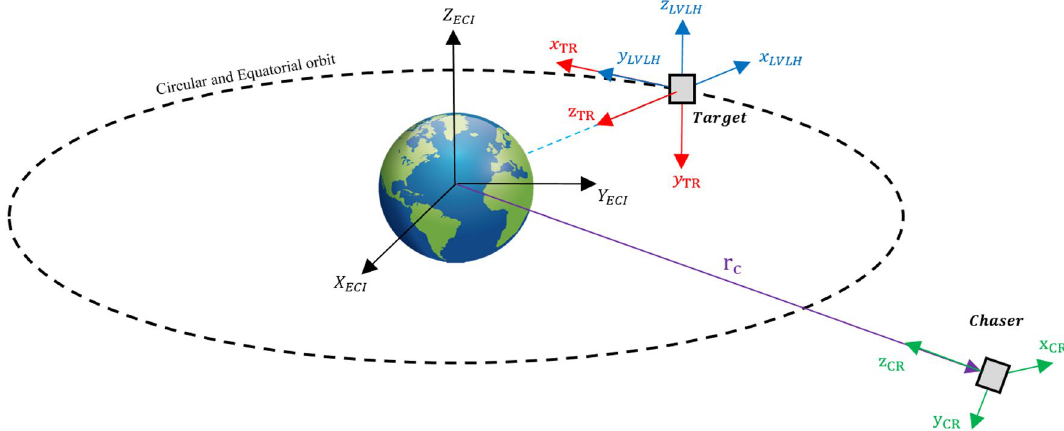
Figure 2. Schematic Definition of LVLH, TR, and CR coordinate systems.